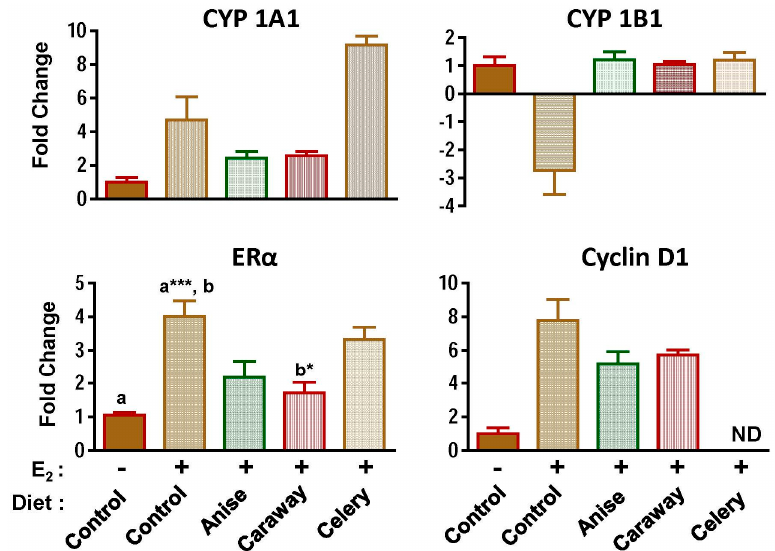
Figure 5. Effect of diet supplemented with anise, caraway, and celery powder (7.5% w / w ) on indicted markers in E2-mediated mammary tumorigenesis. Total RNA was isolated by Trizol method and quantified by Nanodrop. One-Step SYBR green qRT-PCR Kit (Quanta Biosciences, Gaithersburg, MD, USA) was used to perform cDNA synthesis and PCR amplification simultaneously using 100 ng of total RNA as per manufacturer’s instructions. Relative gene expression was normalized to 18s rRNA and assessed using the differences in normalized Ct ( ΔΔ C t). Fold changes were calculated by 2 −ΔΔ C t . Experiments were performed in triplicate for each data point. Data represent mean ± SD of fold change in mRNA expression relative to the untreated control of five animals. Symbols (– and +) denotes the absence and presence of E2, respectively. Alphabets (a and b) followed by asterisk shows statistical differences analyzed by student’s t test where * p < 0.05; *** p < 0.001. ND, not determined.